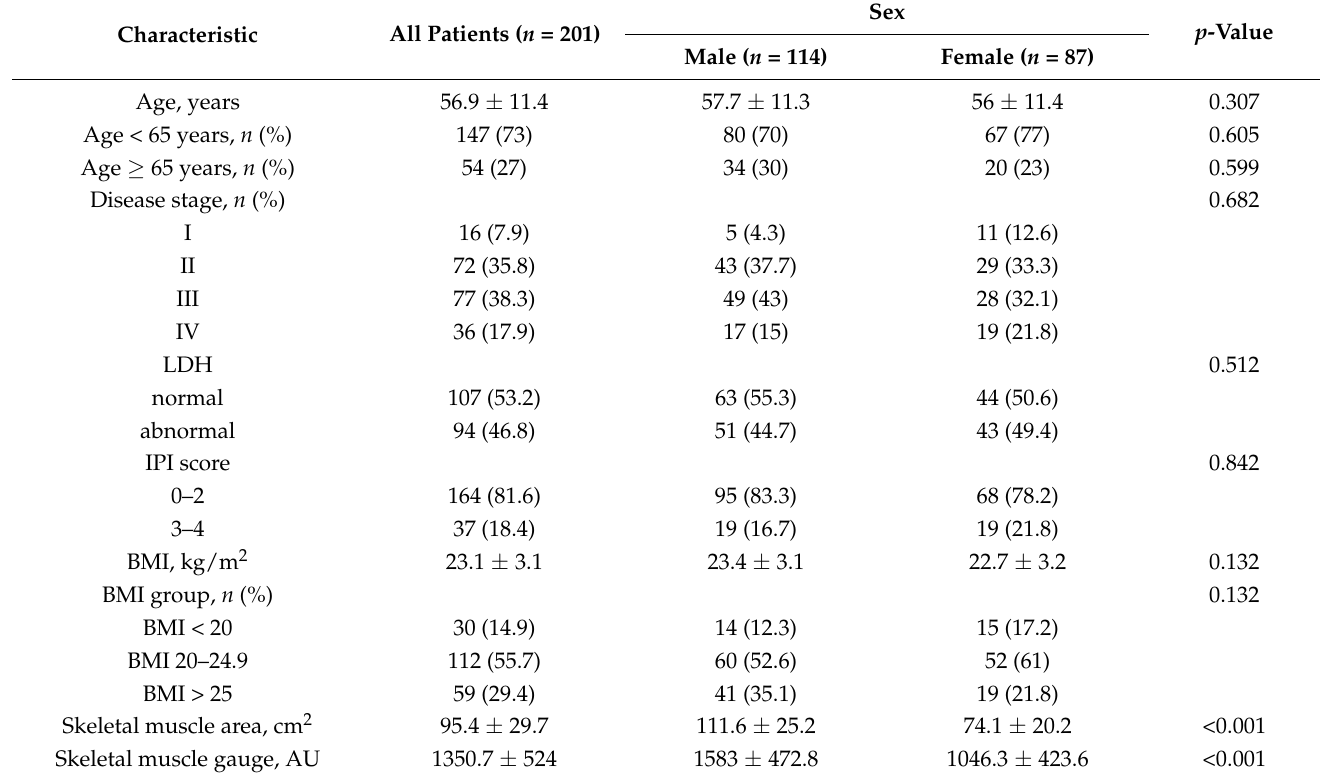
Table 1. Baseline characteristics of diffuse large B-cell lymphoma by